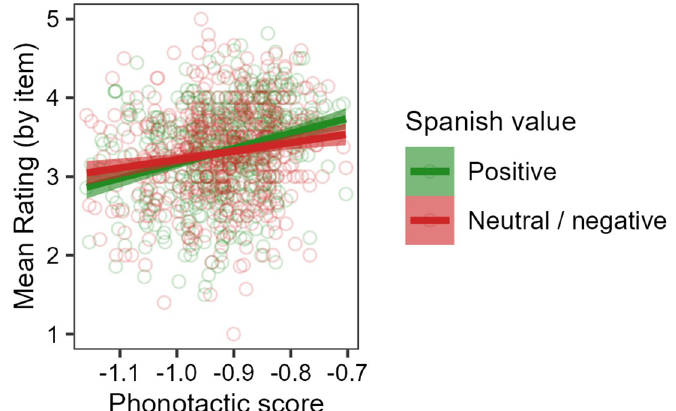
Fig 6. Summary of raw results from Experiment 2, showing participants’ mean wellformedness ratings for each nonword stimulus and their relation to phonotactic score, separating participants with positive Spanish value (green) from those with negative Spanish value (red). Points represent mean ratings for each nonword, and straight lines show correlations with phonotactic scores. In general, ratings increase with phonotactic score, and this pattern appears to be stronger for participants with positive Spanish value than for participants with negative Spanish value; however, the interaction between Spanish value and phonotactic score is not statistically significant.